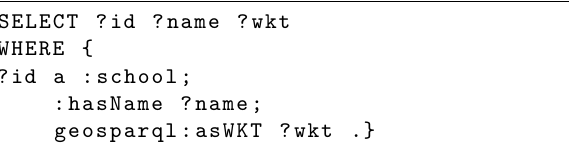
Figure 10. GeoSPARQL query